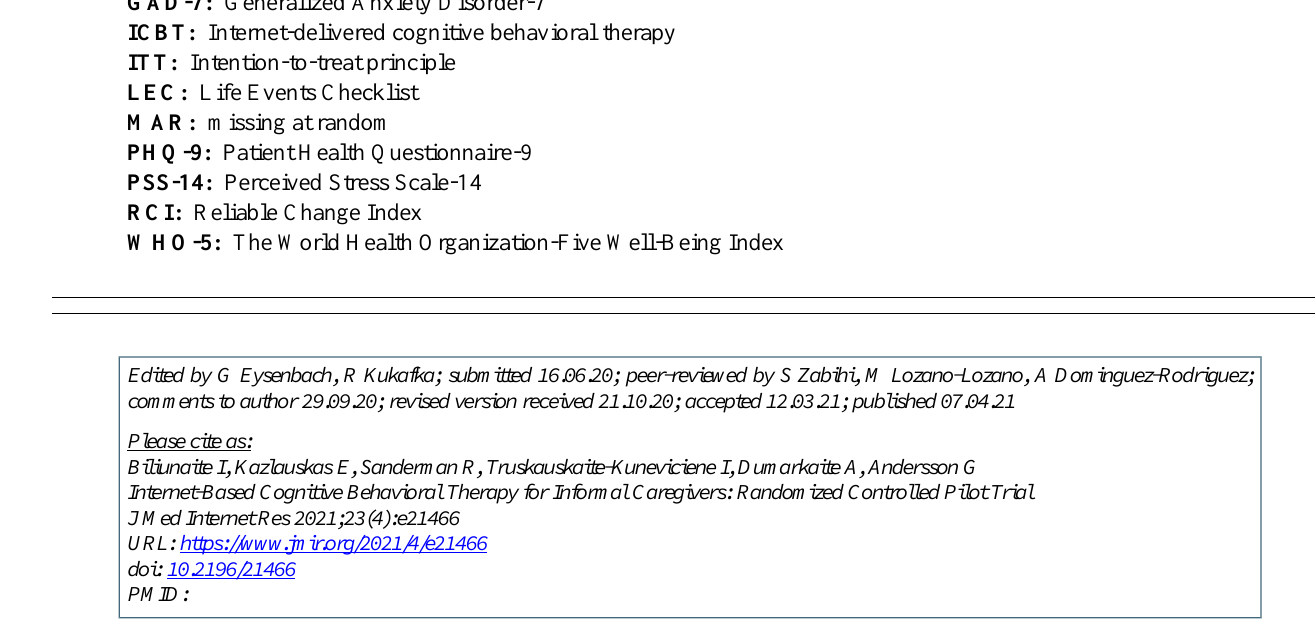
article distributed under the terms of the Creative Commons Attribution